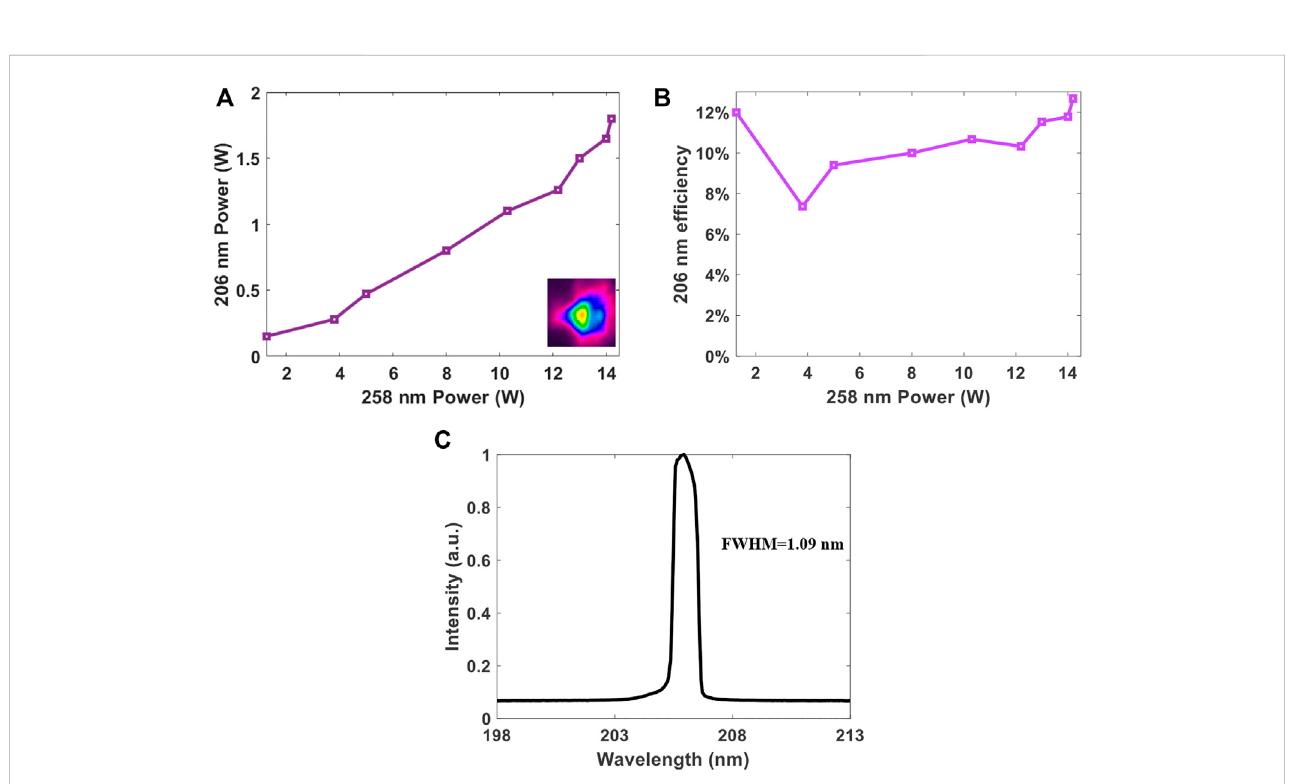
FIGURE 5 Average power (A) and conversion ef fi ciency at 206 nm (B) versus the average pump laser power at 258 nm. The inset in (A) is the beam pro fi le of the output 206-nm beam. (C) Spectrum of the 206-nm laser with a FWHM of 1.09